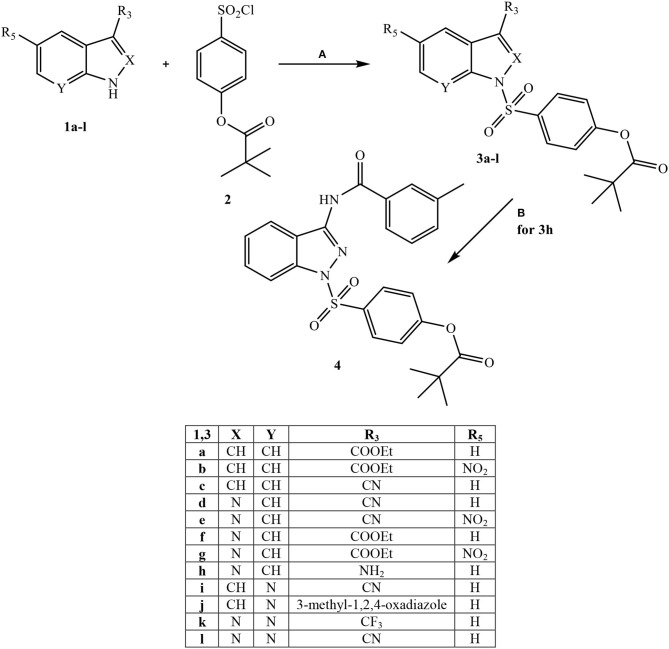
aReagents and conditions. (A) for 3a-c: NaH (60% dispersion in mineral oil), anhydrous THF, r.t., 24 h; for 3d-f and 3i-l: Et3N, anhydrous CH2Cl2, 0°C, 2 h then r.t., 2 h; for 3g: dry pyridine, r.t., 4 h; for 3h: Et3N, dry DMF, 1,4-dioxane, 50 °C, 4h; (B) m-Toluoyl chloride, Et3N, anhydrous CH2Cl2, 0°C, 2 h then r.t., 2 h.